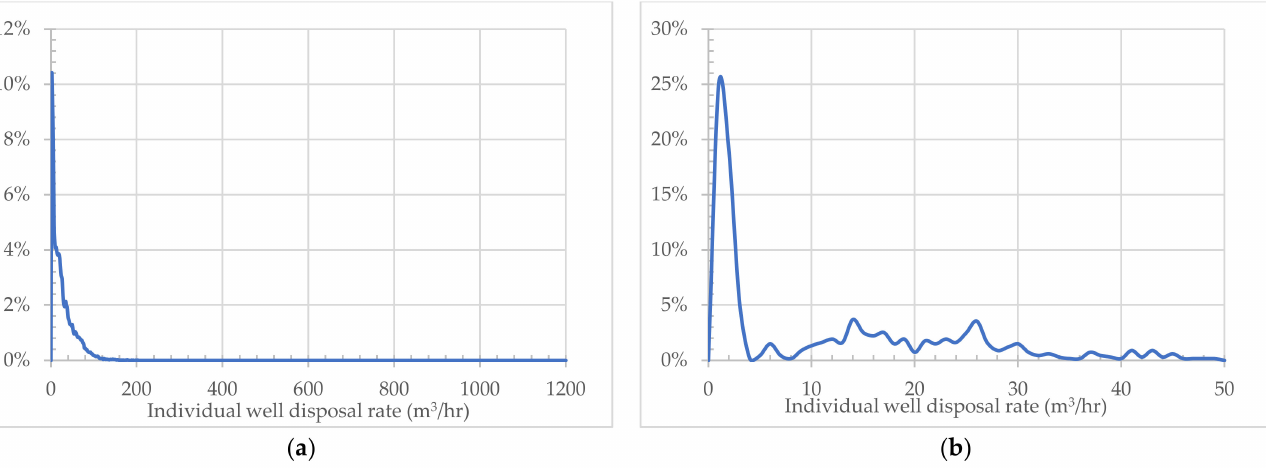
Figure A9. Historical per-well water injection rate ( X -axis) frequency ( Y -axis) distributions (January 1962–December 2022) in ( a ) the Glauconitic Formation; ( b ) the Ostracod